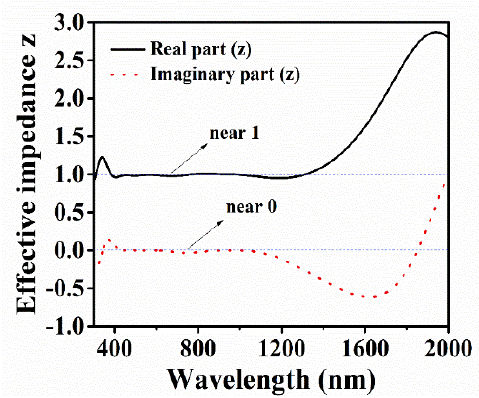
Figure 4. The retrieved effective impedance ( z ) of the MA structure under normal incidence based on the retrieval method.